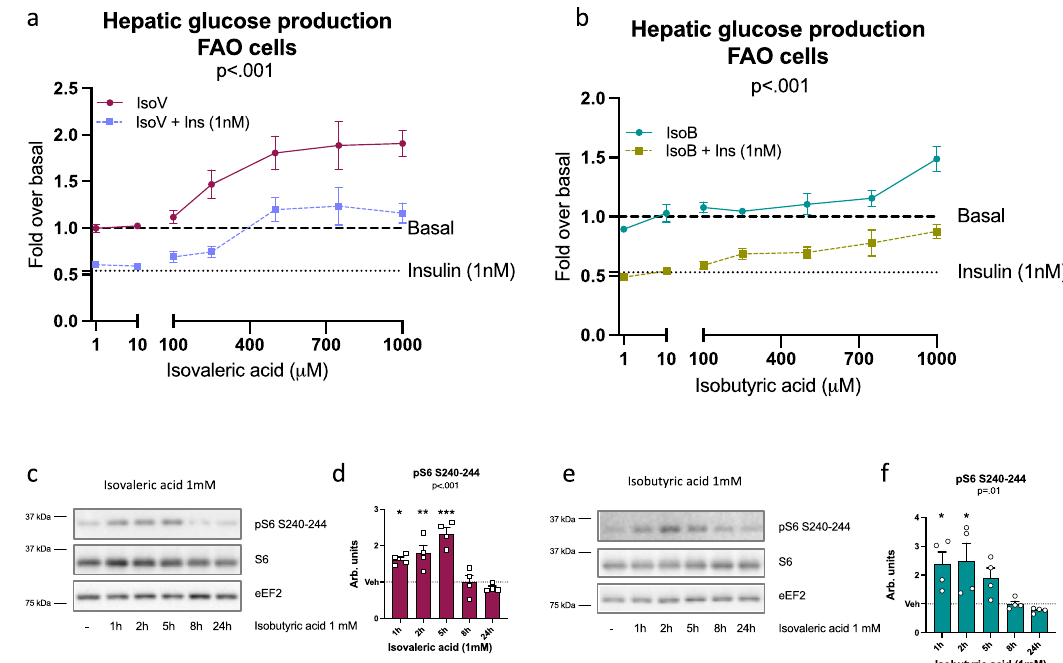
Fig. 7 BCFA increases hepatic glucose production and activates the mTORC1/S6K1 pathway in vitro. Branched-chain fatty acids (BCFA) effect on hepatic glucose production in hepatocytes (FAO) in basal or insulin (1 nM) condition with ( a ) isovaleric (isoV) or ( b ) isobutyric (IsoB) acid (1 – 1000 µ M); data corrected for total protein. For IsoV treatment in basal condition (dark red): n = 6 independent experiments for 1 µ M, 500 µ M and 750 µ M, n = 7 for 10 µ M and 250 µ M, n = 11 for 1 mM, and n = 13 for 100 nM. For IsoV treatment in insulin condition (light purple): n = 5 independent experiments for 750 µ M, n = 6 for 1 µ M, n = 7 for 10 µ M, n = 8 for 250 µ M and 500 µ M and n = 12 for 100 µ M and 1 mM. For IsoB treatment in basal condition (blue- green): n = 6 independent experiments for 250 µ M, n = 7 for 1 µ M, 10 µ M, 500 µ M and 750 µ M, n = 13 for 100 µ M, n = 15 for 1 mM. For IsoB treatment in insulin condition (khaki green): n = 6 independent experiments for 750 µ M, n = 7 for 1 µ M, 10 µ M and 250 µ M, n = 9 for 500 µ M and n = 14 for 100 µ M and 1 mM. Immunoblots and quanti fi cation of densitometry analyses for pS6 S240-244 and total S6 in FAO cells exposed to 1 mM of ( c, d ) isovaleric (dark red) and ( e, f ) isobutyric (blue-green) acid. eEF2 has been used as a loading control and n = 4 independent experiments. Data are means ± s.e.m. A Kruskal-Wallis test followed by a two-tailed Dunn ’ s post-hoc test versus Vehicle/Vehicle + Insulin was performed in each condition and a general p -value is recorded under the title of each graph. Detailed signi fi cant differences detected by post-hoc test are recorded as follows: * p < 0.05, ** p < 0.01, *** p < 0.001. See also Supplementary Fig.